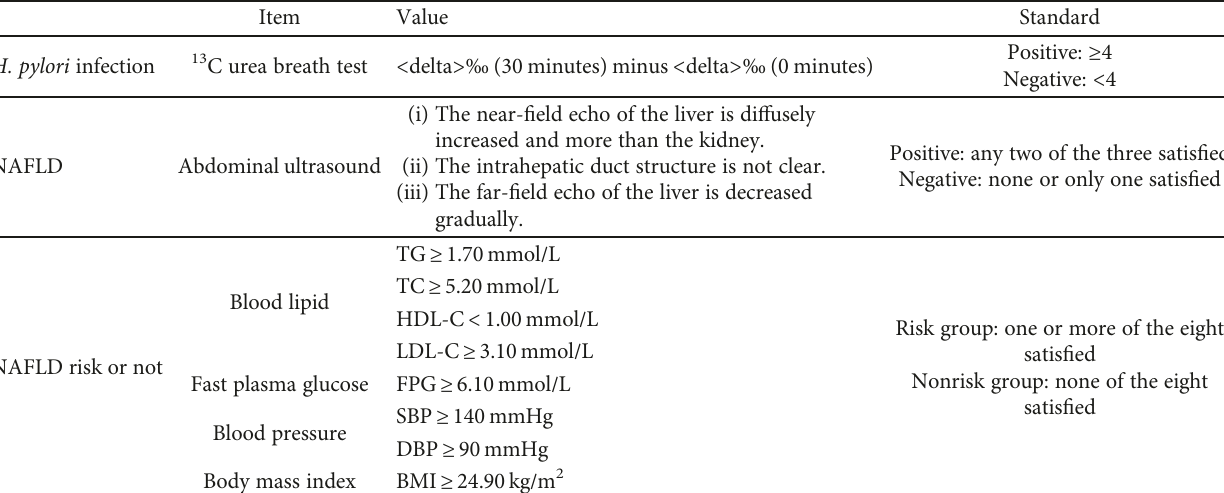
Figure 1: Of the 2985 participants attended, 2051 participants were analyzed in our study. Table 1: De fi nition of H. pylori infection, NAFLD, and NAFLD risk